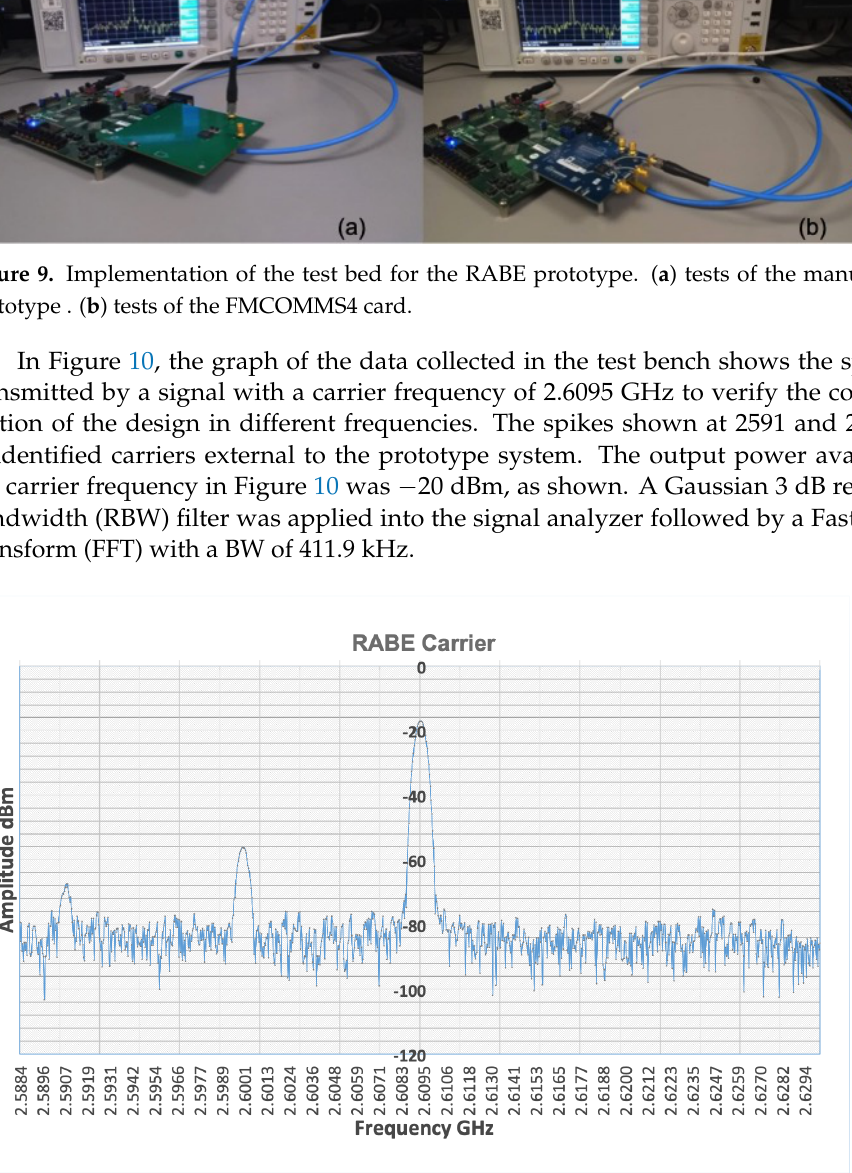
Figure 10. Spectrum of signal transmitted at 2.6095 GHz. Further processing of the data shows the spectrum of the carrier signal transmitted at 2.6095